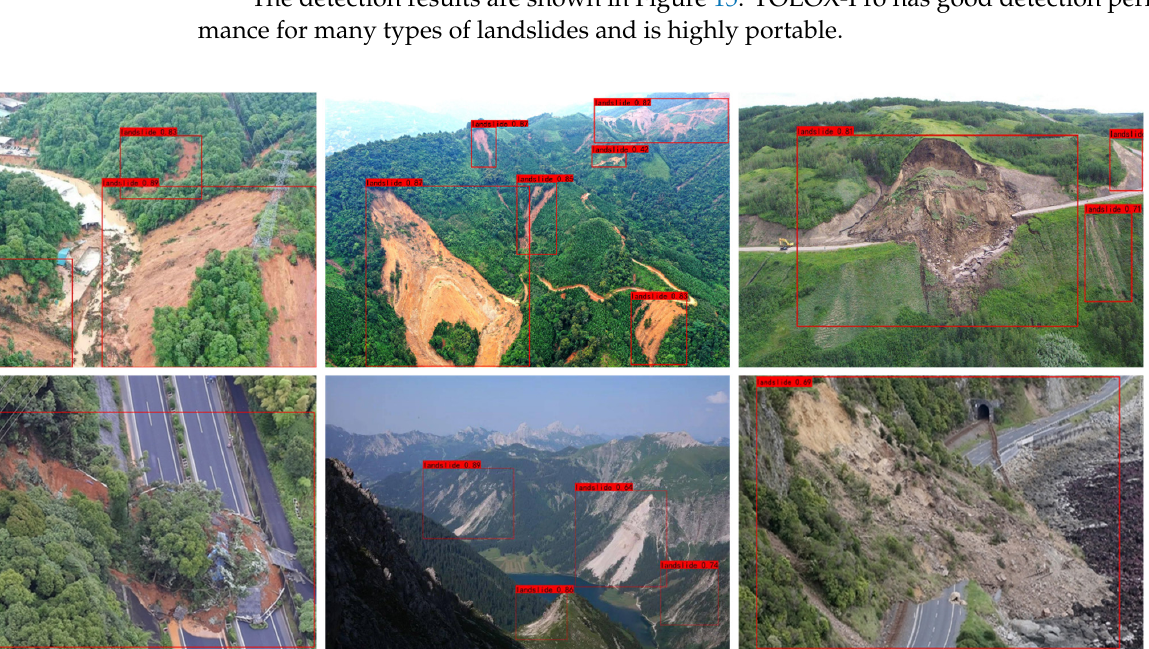
Table 8. Results of the YOLOX-Pro network for detecting the UAV dataset.